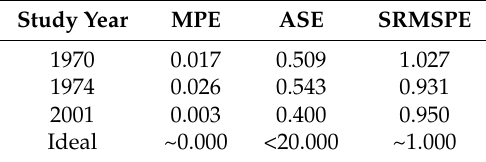
Table 2. Model error